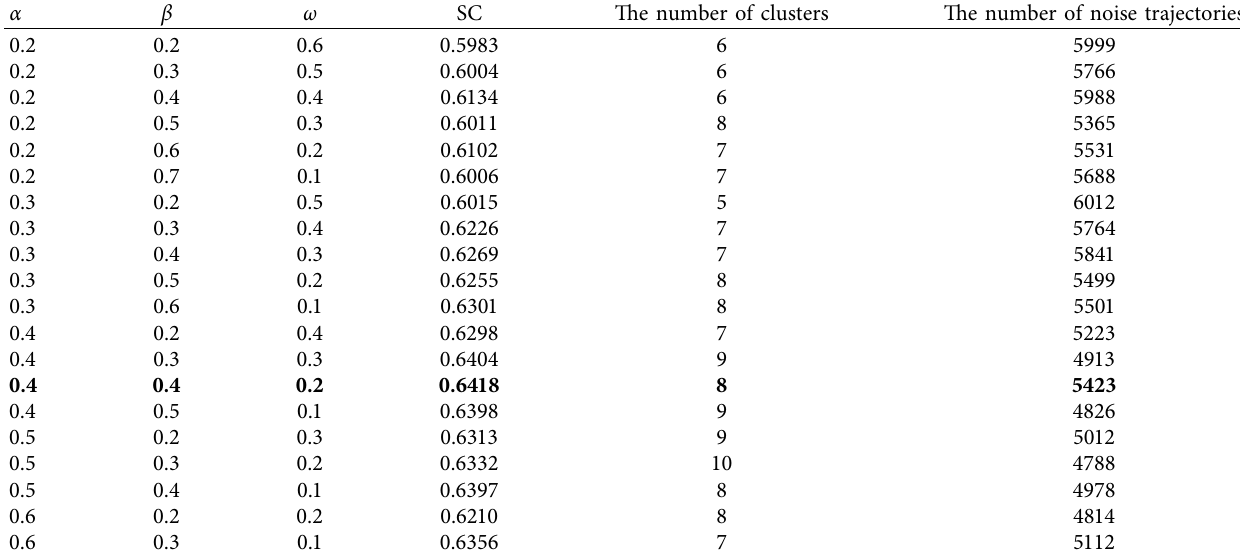
Table 2: Comparison of different parameter combinations for weekend